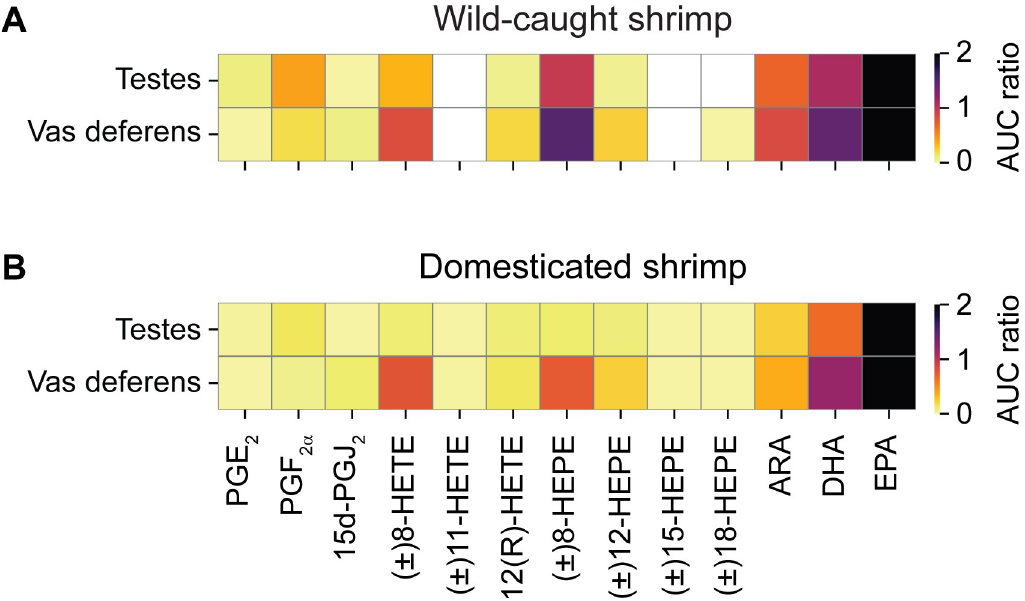
Fig 4. Heat maps illustrating the presence and distribution of eicosanoids and PUFAs in testes and vas deferens of wild- caught and domesticated shrimp. AUC ratio of each metabolite in (A) wild-caught and (B) domesticated shrimp was calculated using the AUC of the respective chromatographic peak divided by the AUC of the internal standard (12(S)-HETE-d 8 ). Metabolite intensities are displayed as colors ranging from yellow to black as shown in the color bar. White indicates that the metabolite was not